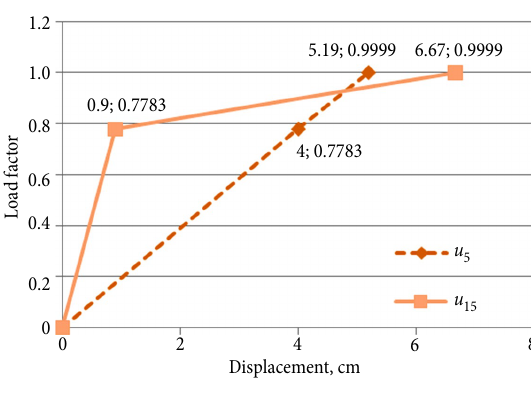
Denmark.Fig. 3. Diagram of load versus Table 4. Displacements of the framing structure